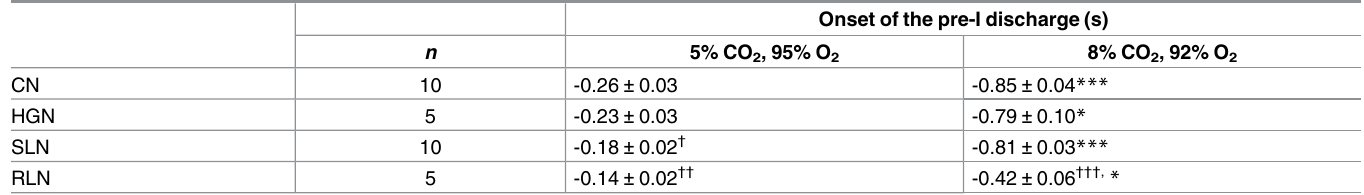
Table 1. The onset of the CN, SLN, HGN and RLN discharges in relation to that of the PN discharge during normocapnia (5% CO 2 ) and hypercapnia (8% CO 2 ).